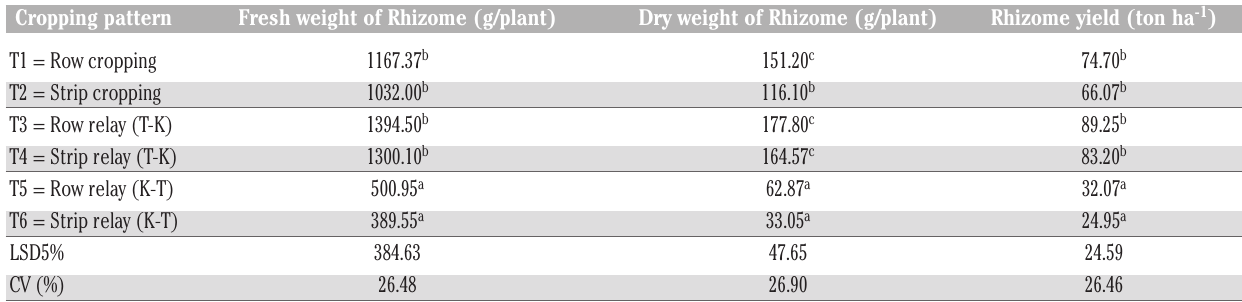
Table 3. Fresh and dry weight of rhizome and total yield of rhizome on various cropping patterns. Cropping